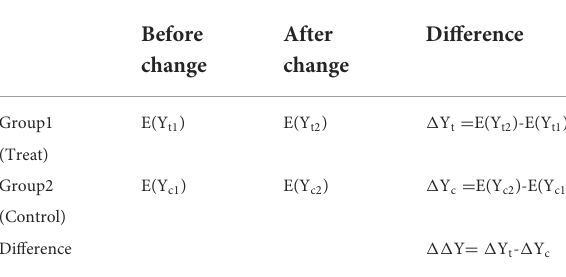
TABLE 2 β 3 Effects in the DID